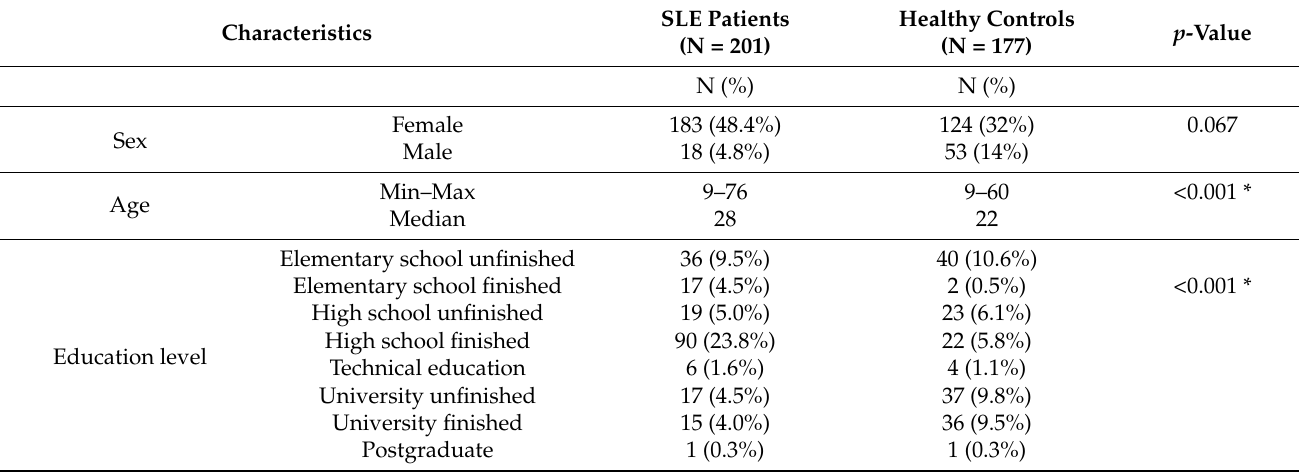
Table 1. Sociodemographic